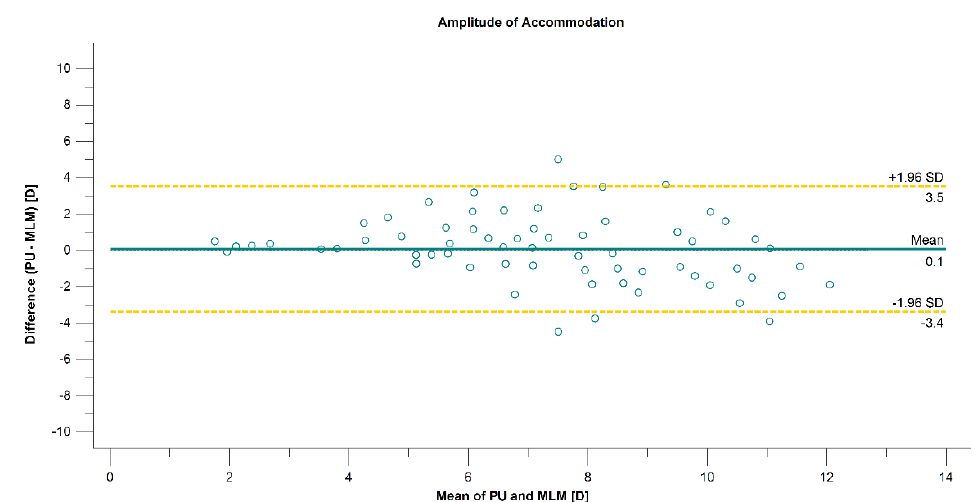
Figure 5. Agreement in amplitude-of-accommodation measurements between the push-up and minus-lens methods associated with 95% CI for difference.